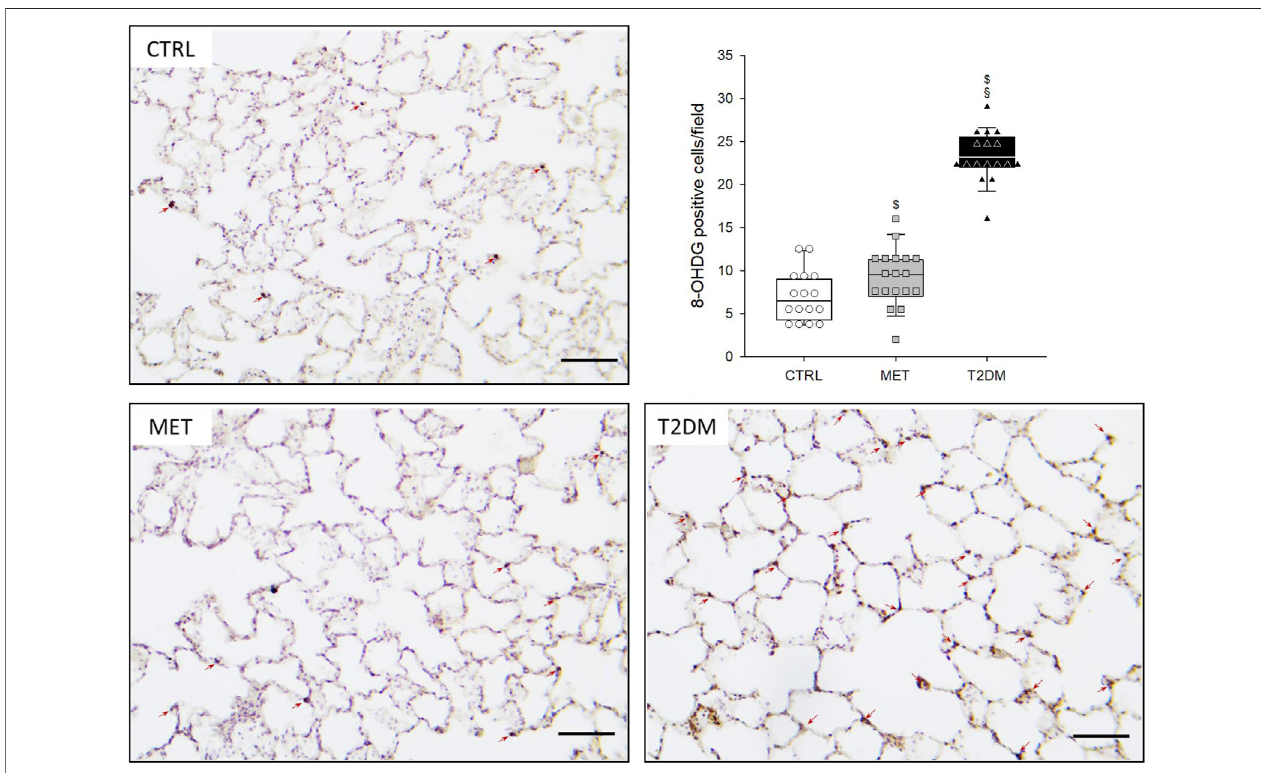
FIGURE 6 | Representative lung sections of the three study groups stained with anti-8-OHDG immunohistochemistry. Red arrows indicate the 8-OHDG-positive cells (magni fi cation × 200; scale bar: 100 µm). Abbreviations: CTRL, control group; MET, metformin-treated model oftype 2diabetes; T2DM, untreated model of type 2 diabetes. Graph represents the number of anti-8-OHDG positive-stained cells in the three study groups. $ p < 0.05 vs . CTRL; § p < 0.05 vs . MET.